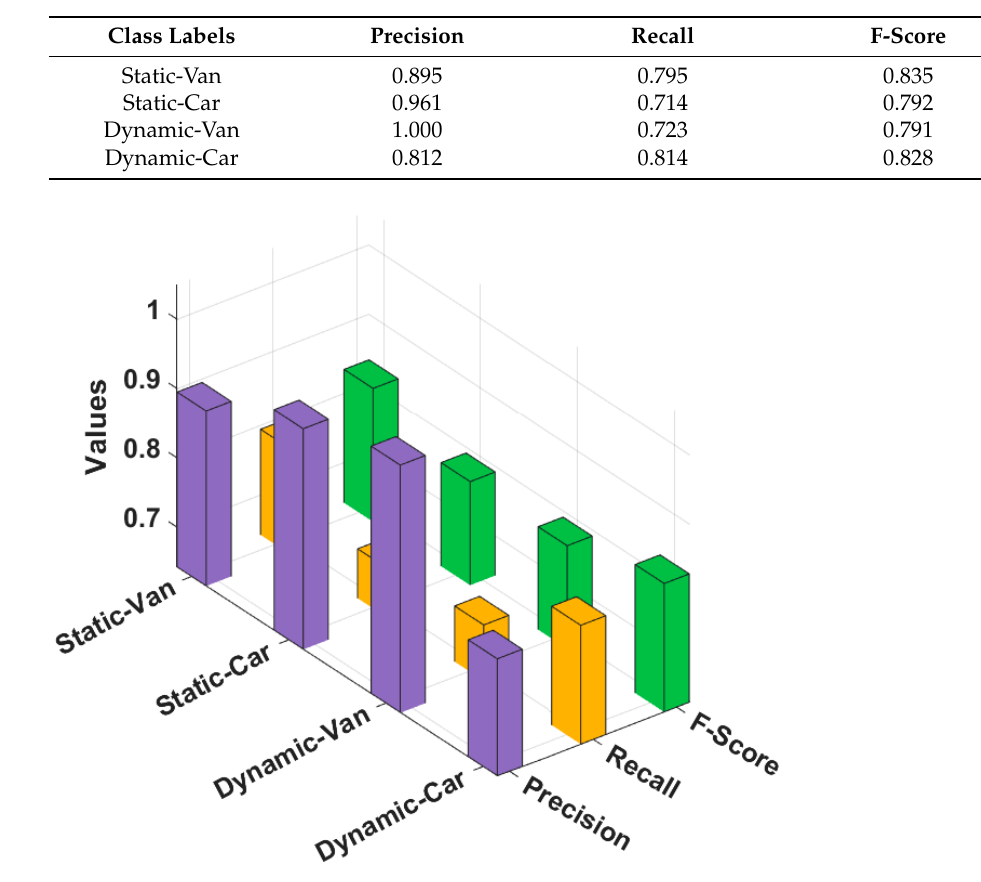
Figure 6. Classifier Results of CIWHO-ORC technique on KITTI MOD dataset.